Question: Looking at the figure, what chart type is it?
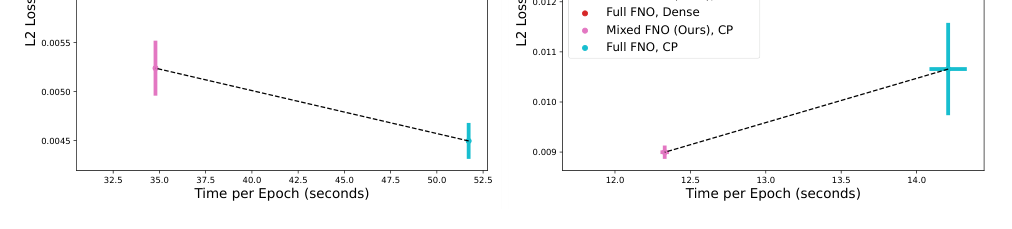
Answer: line